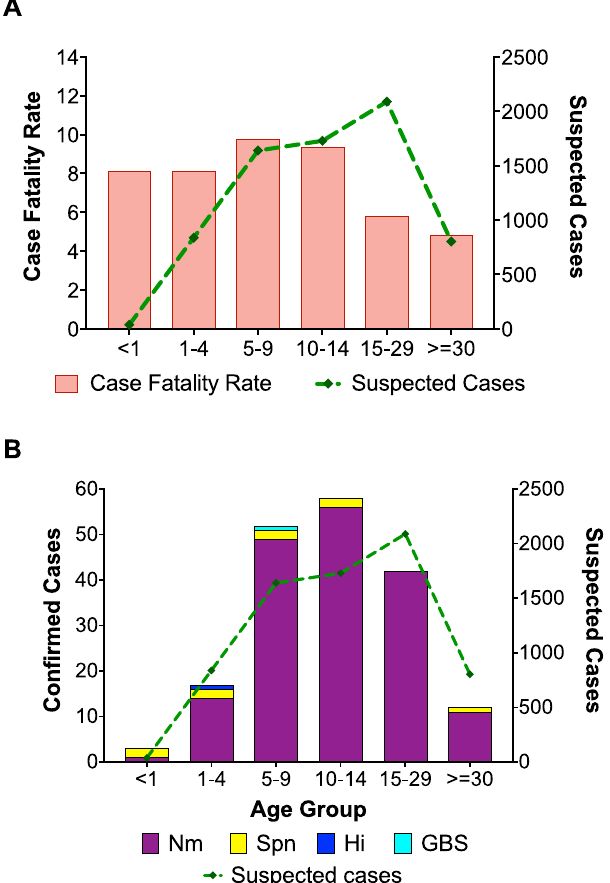
Figure 4. Case fatality rates and laboratory-confirmed cases by age group in Zamfara State. The case fatality rates and total suspected cases are shown by age group ( A ). The distribution of pathogens among laboratory- confirmed cases by age-group ( B ). The suspected case counts by age group are presented in Table